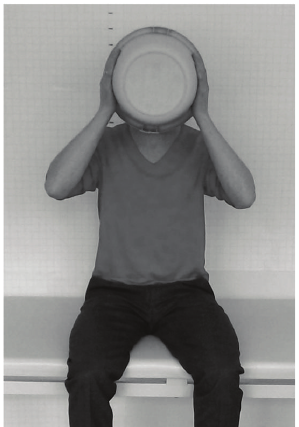
Figure 1: Testing the subjective visual vertical with the adapted bucket